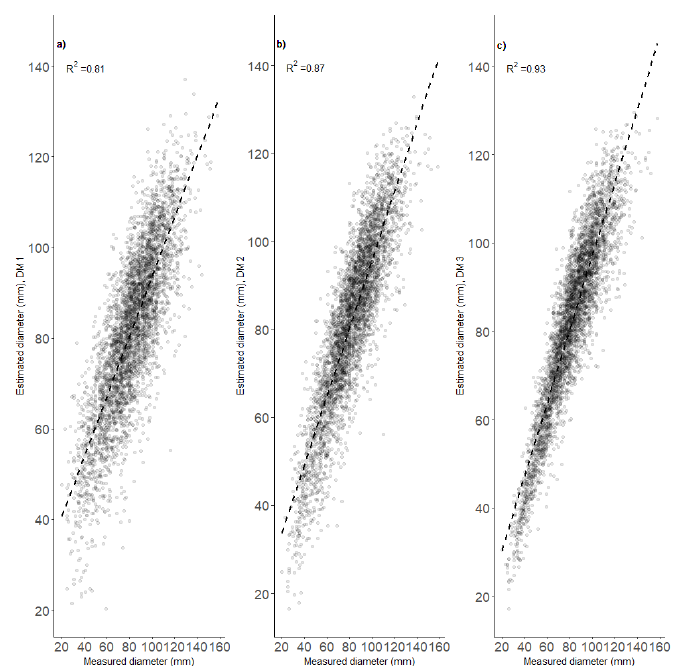
Figure 3. Linear fits between manual measurements and image-based estimates of diameter at the age of 12 years provided by three developed models (DM1—( a ), DM2—( b ) and DM3—( c )).